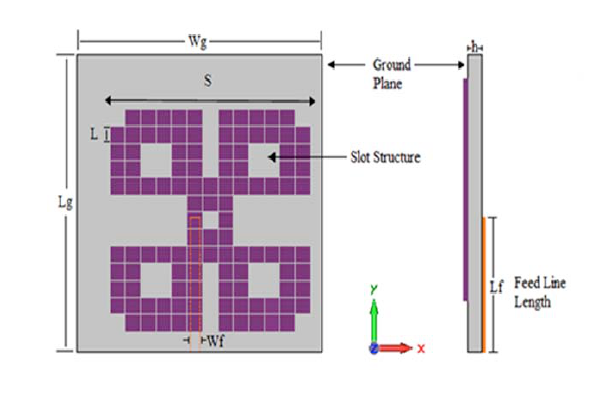
Figure 2: The quasi-fractal antenna